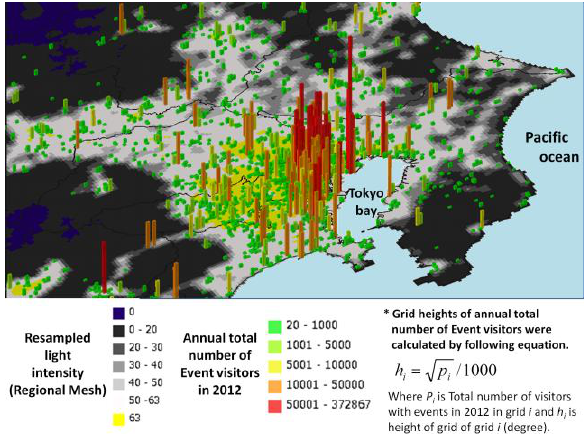
Figure 8. Spatial distribution of annual total number of Event visitor and resampled light intensity in Tokyo metropolitan area